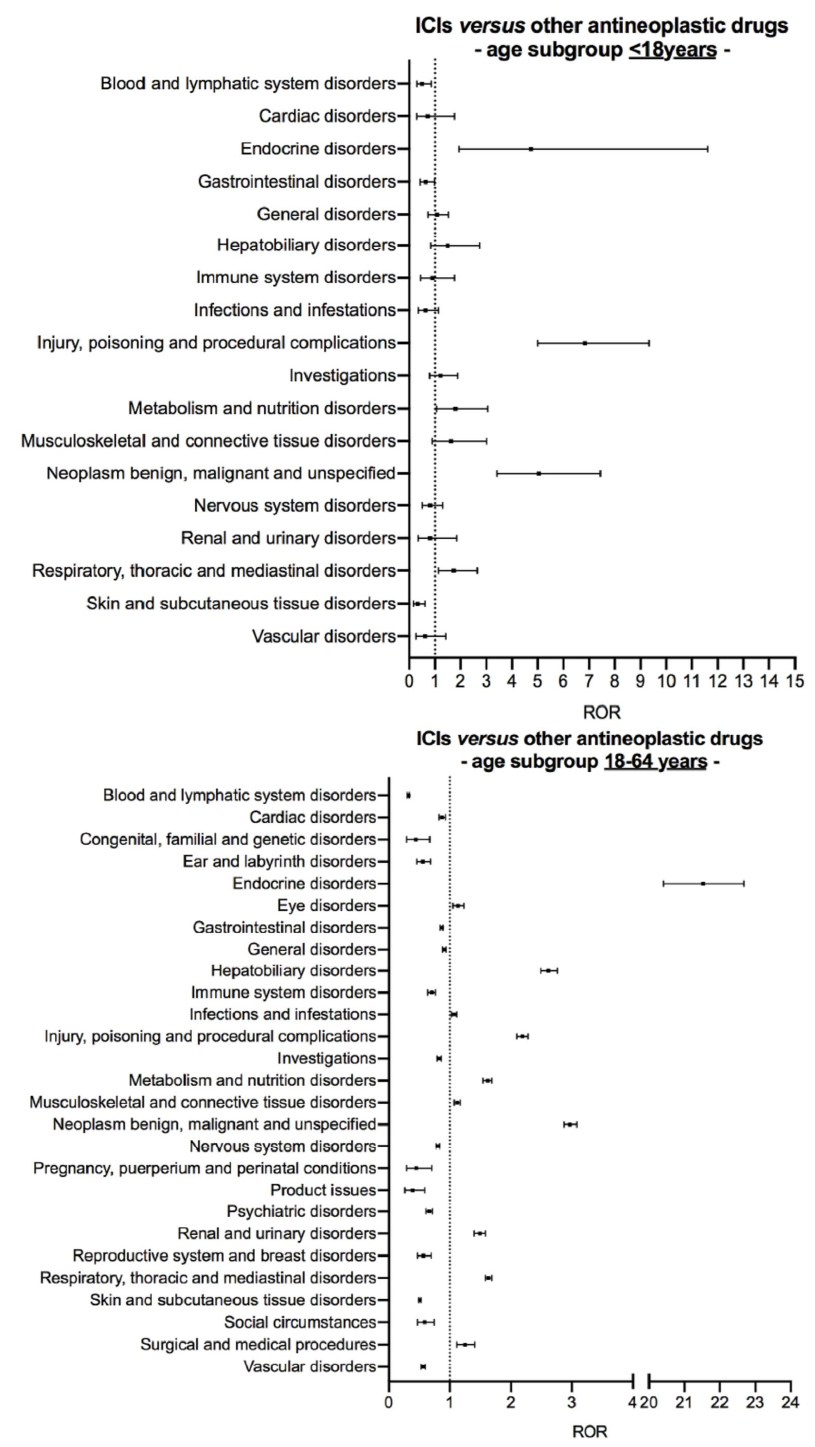
Figure 3. Age subgroup disproportionality analysis of safety reports associated with either immune checkpoint inhibitors or other antineoplastic drugs in younger patients (aged <65 years). Suspected adverse drug reactions were clustered according to the Medical Dictionary for Regulatory Activities (MedDRA) System Organ Classes, version 23.0. Vertical bars on the ROR estimates indicate the 95% confidence intervals. Abbreviations: ICI, immune checkpoint inhibitor; ROR, reporting odds